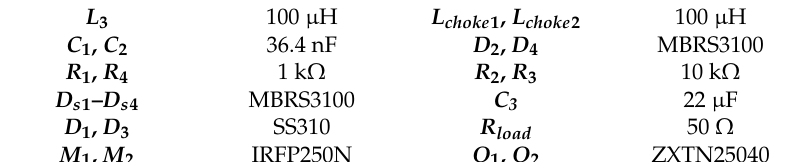
Table 3. Parameters and components of the improved circuit.